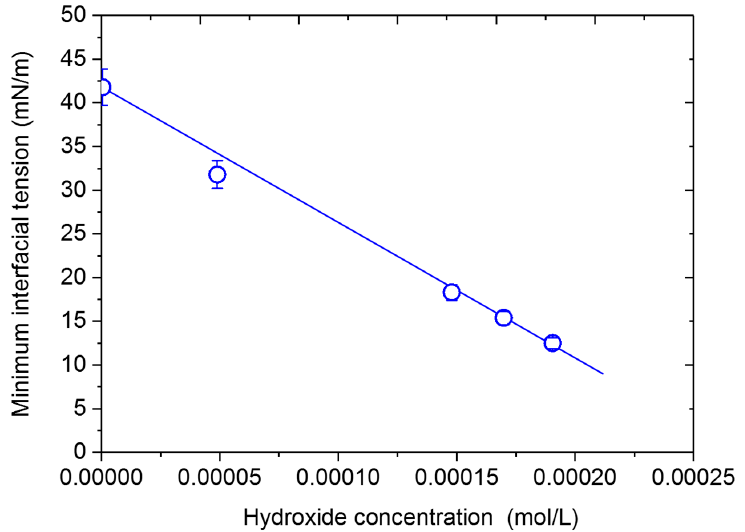
Figure 2. Relationship between the minimum interfacial tension and hydroxide ion concentration.